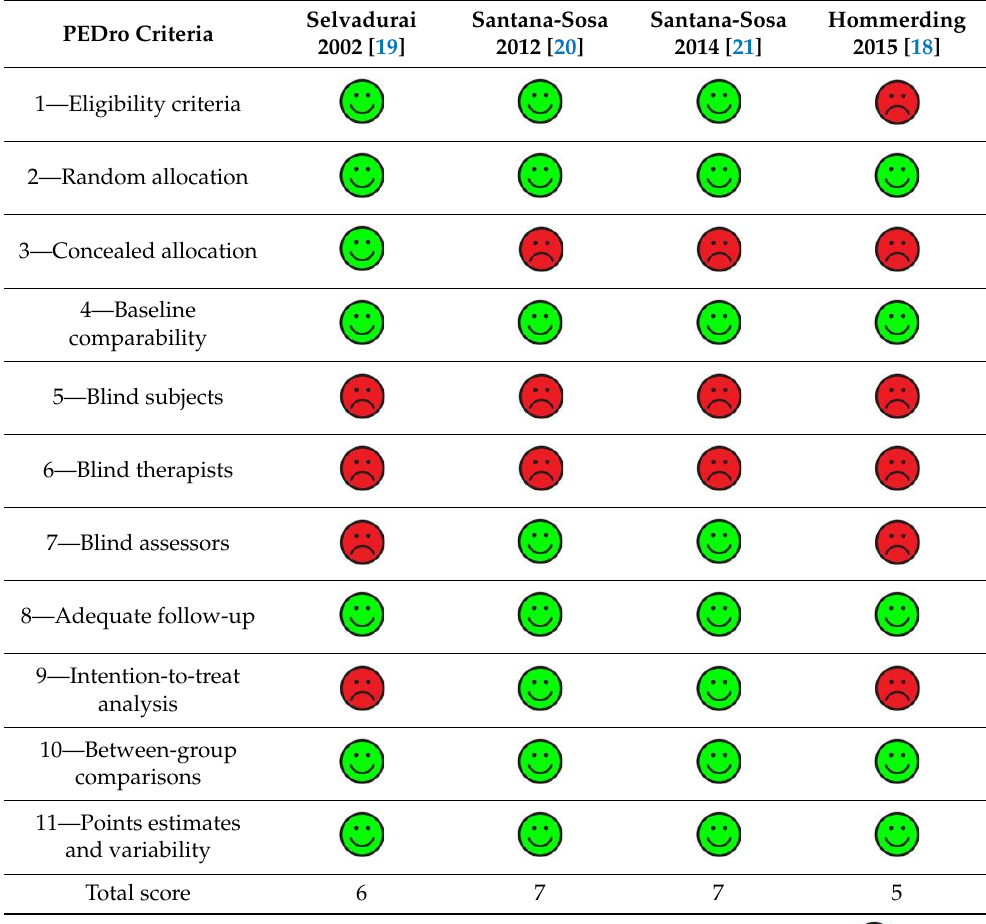
Table 5. Methodologic quality and statistical reporting assessment, using the PEDro scale, of ran- domized controlled trials evaluating the effect of exercise on anthropometric outcomes in people with CF.